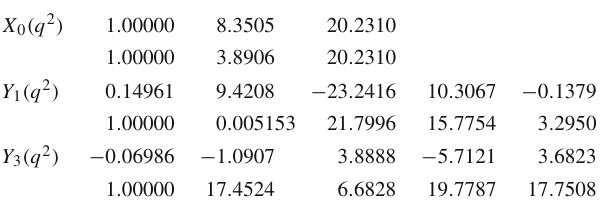
Table1 CoefficientsofthePadéapproximantin(31)inpowersofGeV. For each function, the upper line refers to the numerator coefficients in increasing power of q 2 , while in the lower line are the coefficients for the denominator polynomial in increasing powers of q